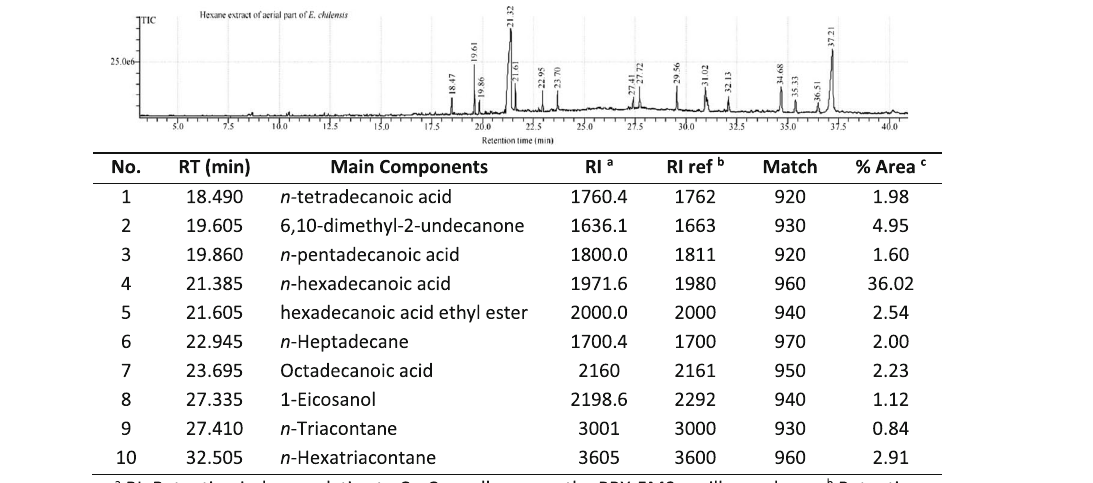
Table 8). The analysis did not identify ephedrine,